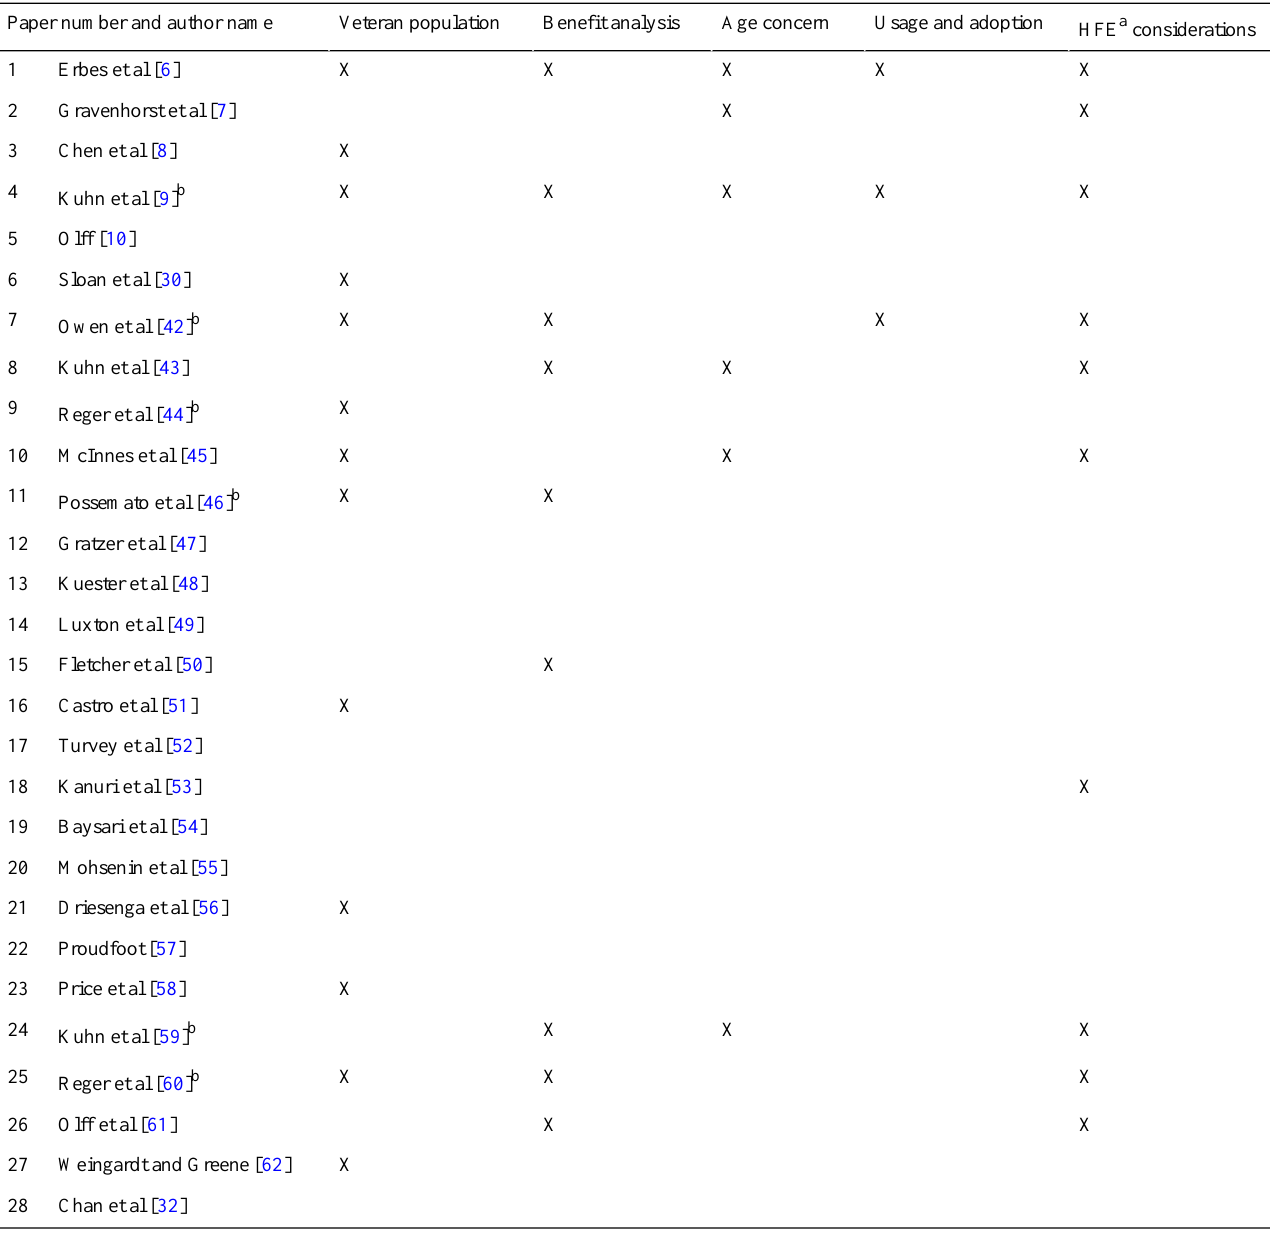
Table 3. The 28 papers meeting the inclusion criteria. The headers are the categories of gaps identified. An “X” in the column indicates that the papers worked to address this